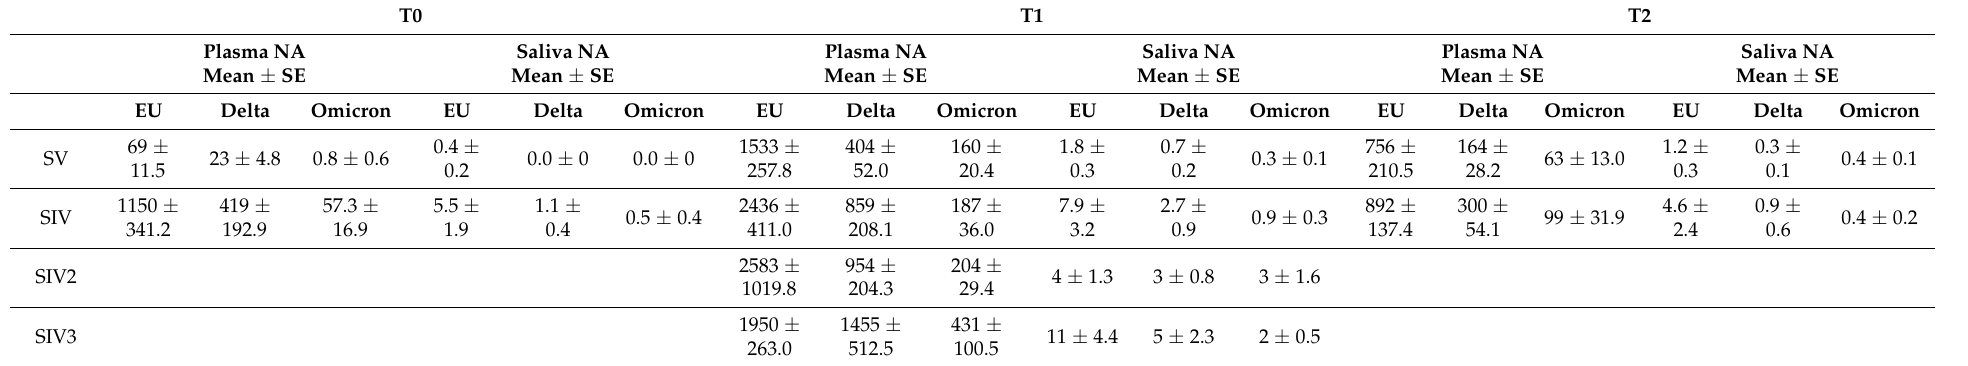
Table 1. Mean value of the neutralizing activity (NA) in plasma and saliva samples of the different enrolled groups over time. T0 T1